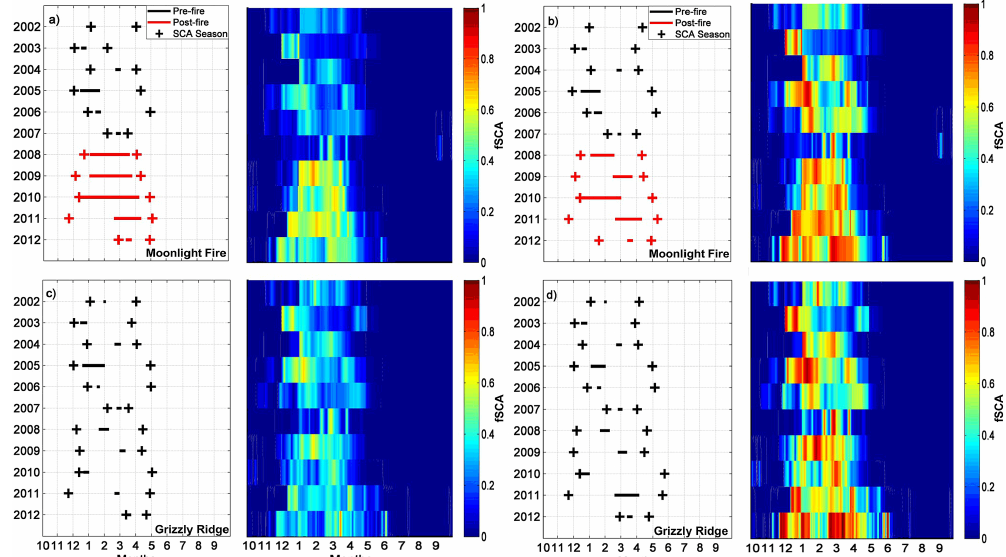
Figure 6. Temporal trends in snow cover of the consecutive number of high snow-cover days (pre-fire exceedance probability ≤ 10%; represented by black and red lines) with respect to the length of snow season (exceedance probability ≥ 70%; represented by black and red crosses) for Grizzly Ridge (c) and (d) and the Moonlight Fire area (a) and (b) . Color maps show annual daily basin-averaged fSCA patterns. (b) and (d) are canopy-adjusted MODSCAG